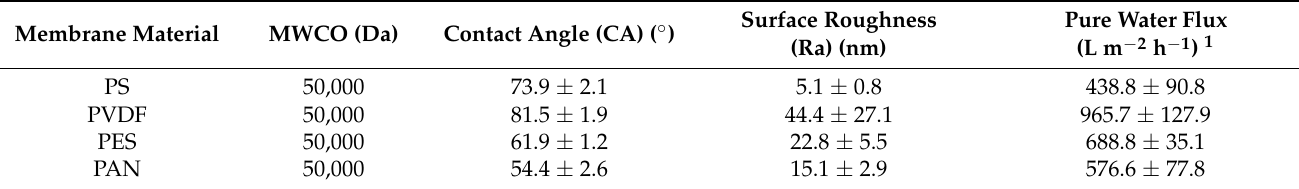
Table 3. Characteristics of commercial membranes used in this